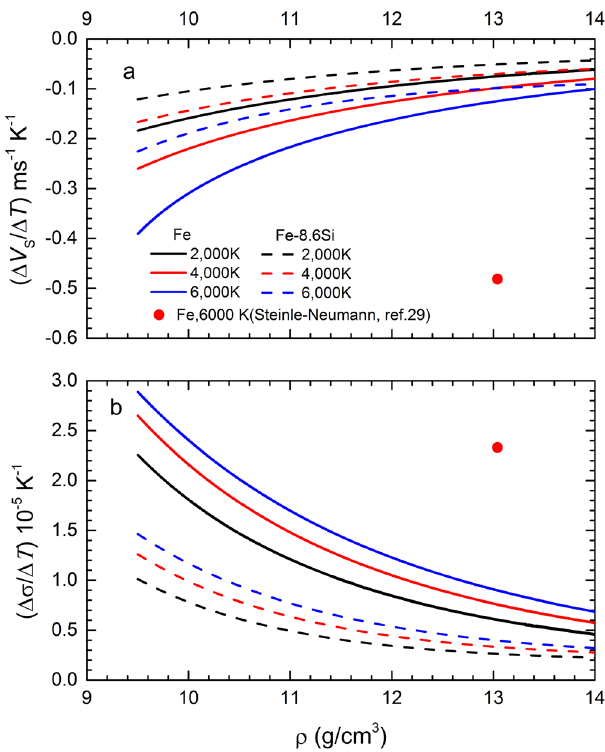
Fig. 3 The rate of change of V S and σ in temperature as a function of density at different temperatures. a The calculated Δ V S / Δ T increase with density along 2000K (black line), 4000 K (red line) and 6000 K (blue line) isotherms. b The calculated Δ σ / Δ T decrease with density along 2000 K (black line), 4000 K (red line) and 6000 K (blue line) isotherms. The solid and dashed lines represent the values of Fe and Fe-8.6Si, respectively, compared with the ab initio calculations (red solid circle) 29 .